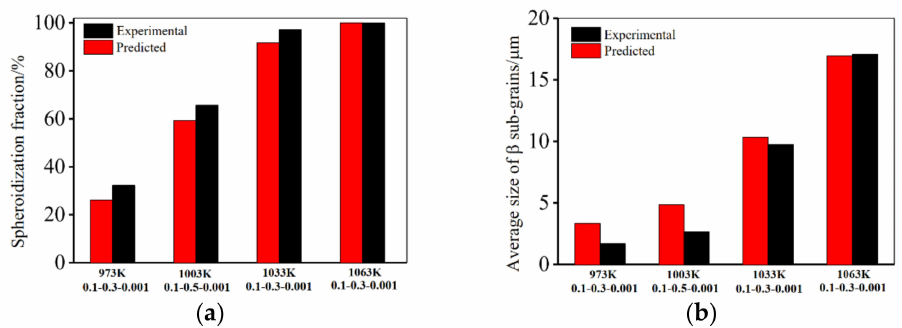
Figure 9. Comparisons of the calculated and experimental: ( a ) spheroidization fractions of α L ; ( b ) average sizes of β subgrains.